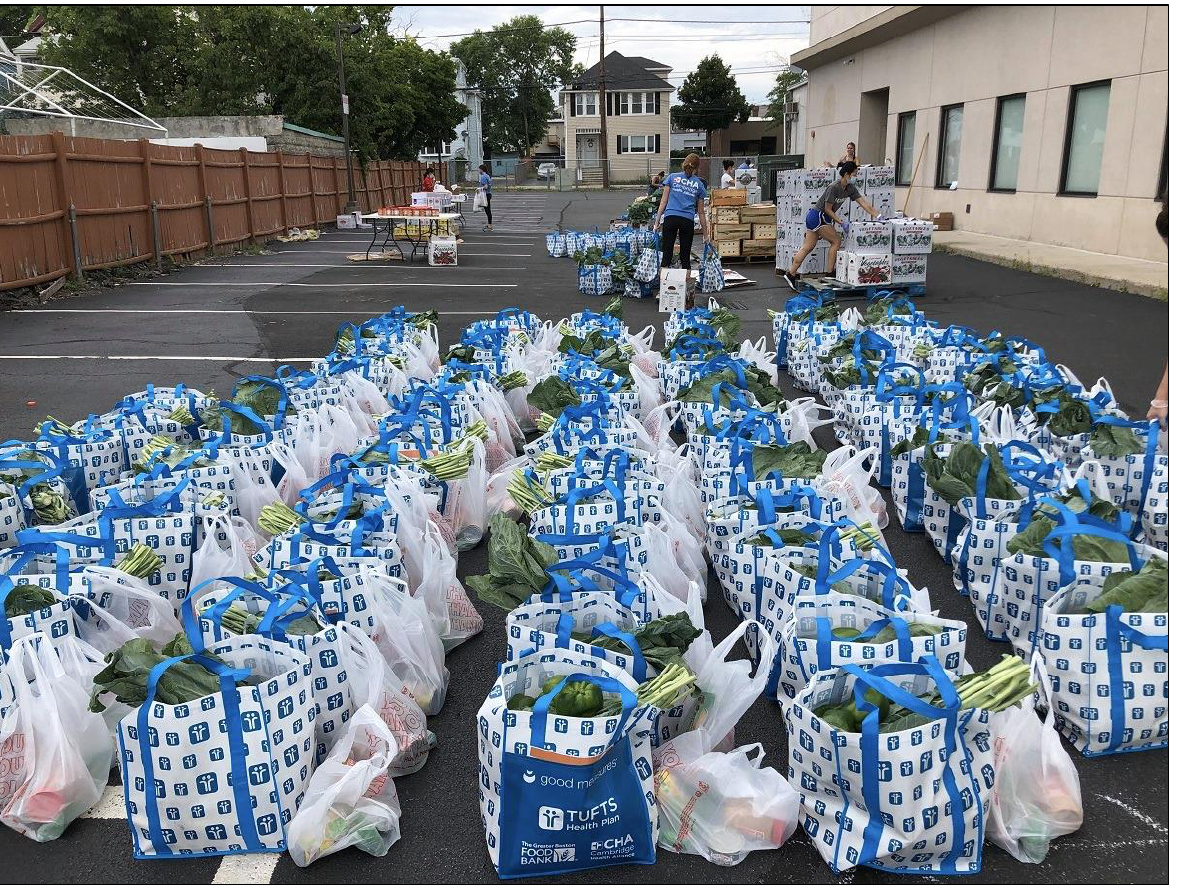
Figure 4. CHA Produce Market Expands to Meet Community Food Needs Throughout COVID-19